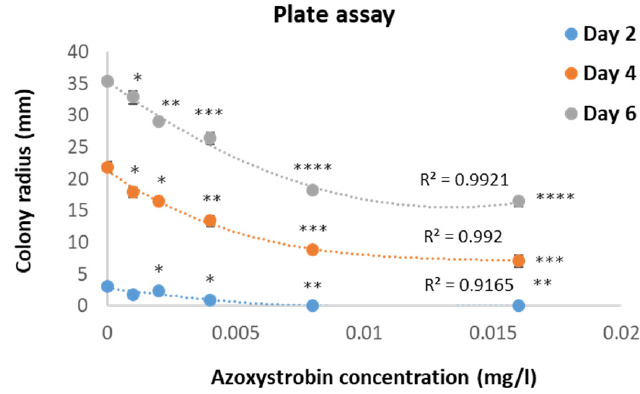
Figure 2. Azoxystrobin plate inhibition assay. The sensitivity of Magnaporthiopsis maydis to increased concentrations of the active ingredient (0–0.016 mg/L) was evaluated in solid potato dextrose agar (PDA) medium. Each growth plate was inoculated by a mycelial disk (6 mm in diameter) cut from the margin of 4–6-day-old colony. The cultures were incubated at 28 ± 1 °C in the dark for 2–6 days.